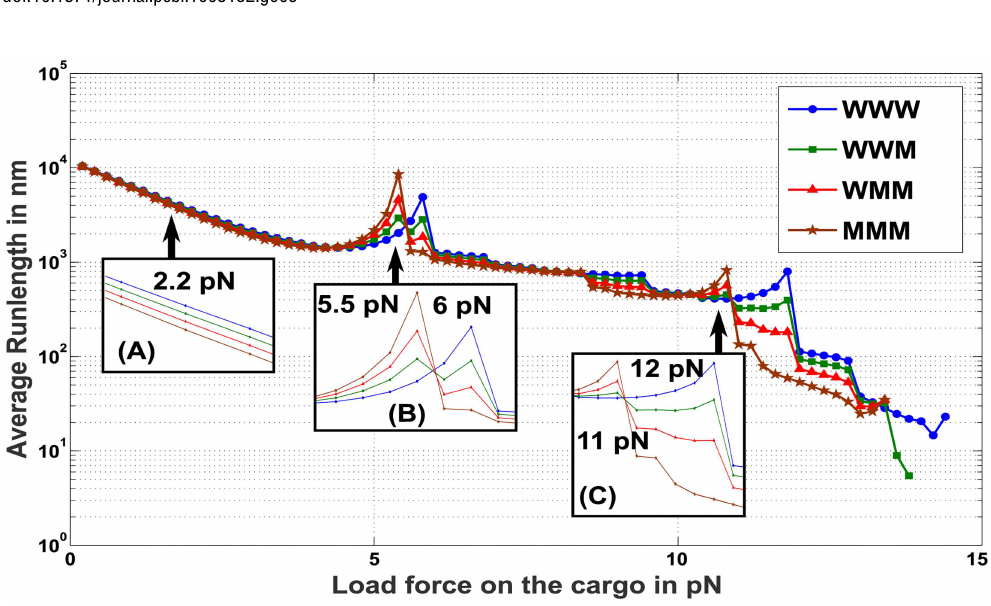
Fig 10. Average Run-length under different load forces on a cargo with ensembles of three motors, wild type and mutant (WWW, WWM, WMM and MMM). (A) Average Run-lengthof ensembles subjected to load forces around 2.2 pN . Ensembleswith a higher proportionof mutant motors demonstrate lower average run-length ¼ 5 : 5 pN than the rest of the ensembles. (B) Average Run-lengthof ensembles subjected to load forces around (cid:22) F s ¼ 5 : 5 pN , ensembleswith more mutant motors travel farther, whereas near F s = 6 pN , and F s = 6 pN . Near (cid:22) F s ensembleswith more wild-type motors travel farther. (C) Average Run-lengthof ensemblessubjectedto load ¼ 11 pN and 2 F s = 12 pN . Again, near 2 (cid:22) F ¼ 11 pN , ensembleswith more mutant motors travel forces around 2 (cid:22) F s s farther, whereas near 2 F s = 12 pN , ensembleswith more wild-typemotors travel